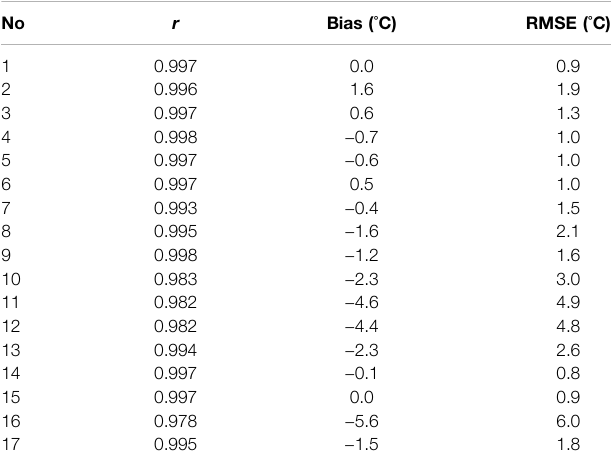
TABLE 2 | Comparison of ERA5-Land monthly averaged temperatures with observations at all 17 stations.